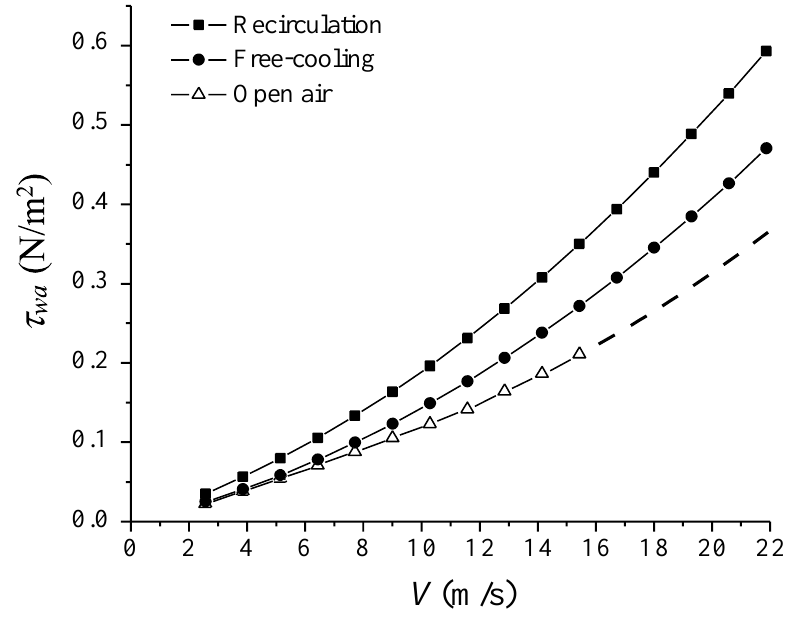
Figure 10. Averaged wall shear stress τ wa in the two ventilation modes and in the open air.